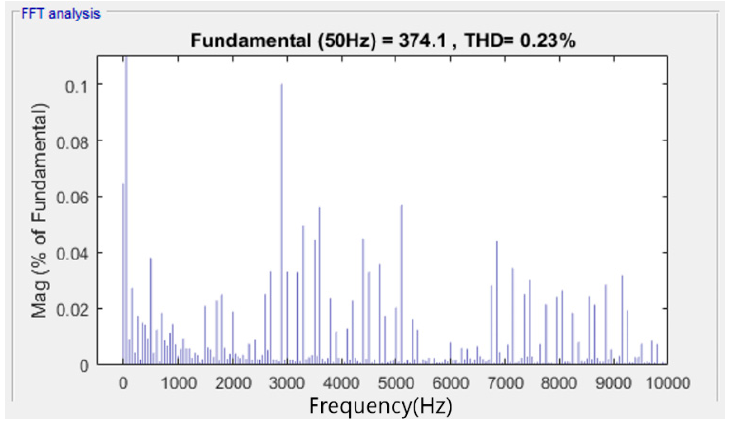
Figure 14. Three-phase four H-bridge CHB inverter current THD for LS PWM and equal sources.